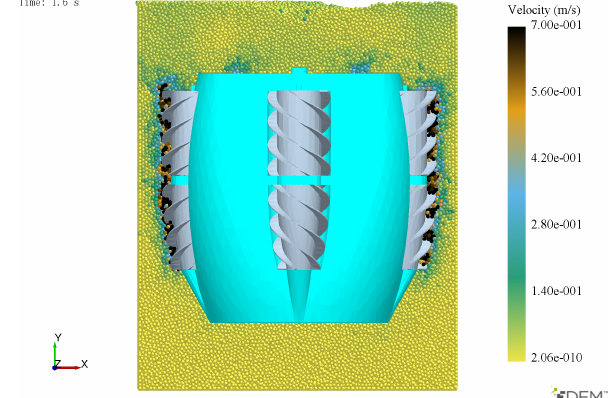
Figure 13. Particle velocity around the